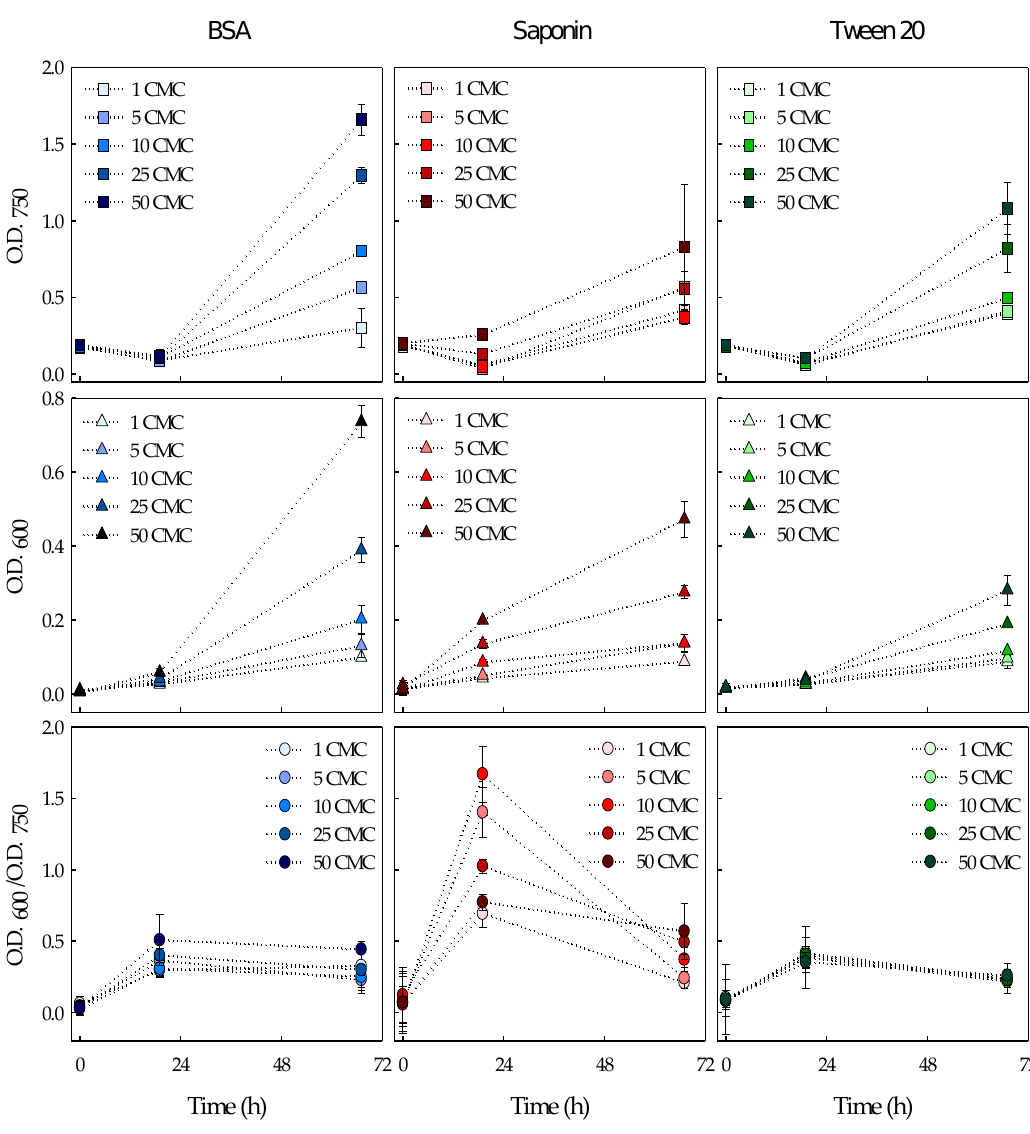
Figure 1. Scenedesmus obliquus (upper figures) and bacterial (middle figures) growth expressed as optical density at 750 nm (O.D. 750 ) and 600 nm (O.D. 600 ), respectively. Bacteria to microalgae ratio (lower figures) expressed as the ratio between the optical density at 600 and 750 nm (O.D. 600 /O.D. 750 ). Cultures with BSA ( left ), Saponin ( middle ) and Tween 20 ( right ) at concentrations of 1, 5, 10, 25 and 50 CMC. The average values of duplicate cultures are shown, together with their corresponding standard deviations.